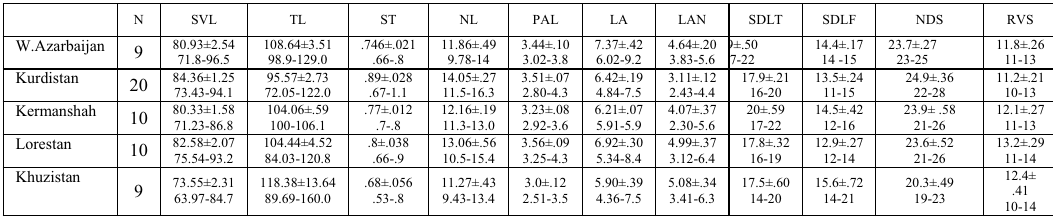
characters among populations in two taxa of the genus Trachylepis.